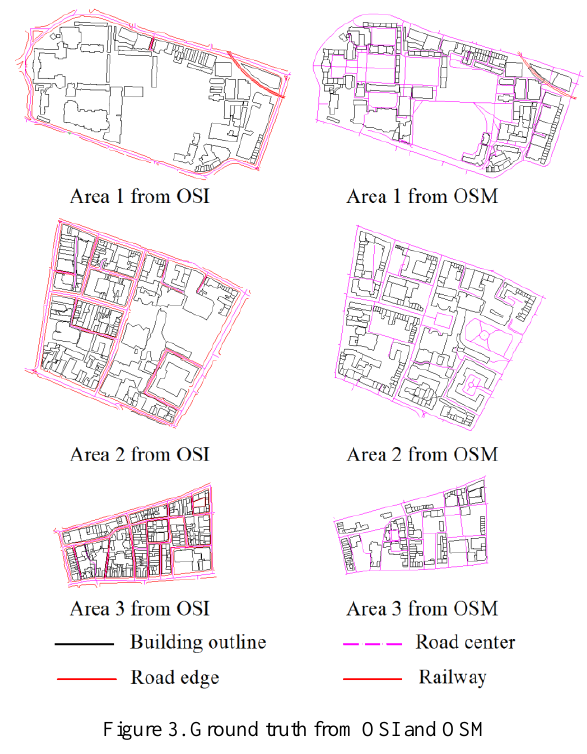
Figure 3. Ground truth from OSI and